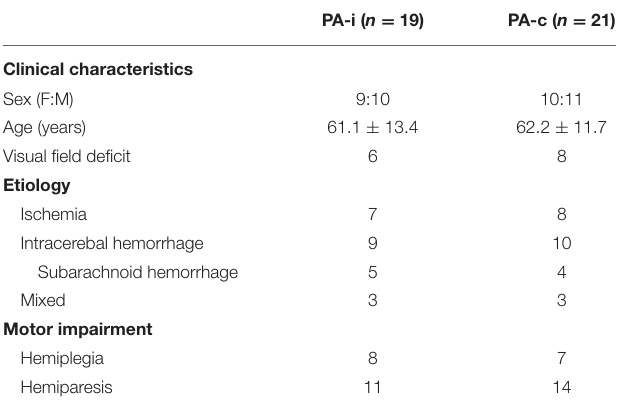
TABLE 1 | Clinical characteristics of the two combined PA groups (both series and after completing both conditions of cross-over design) following an intermittent or continuous protocol.